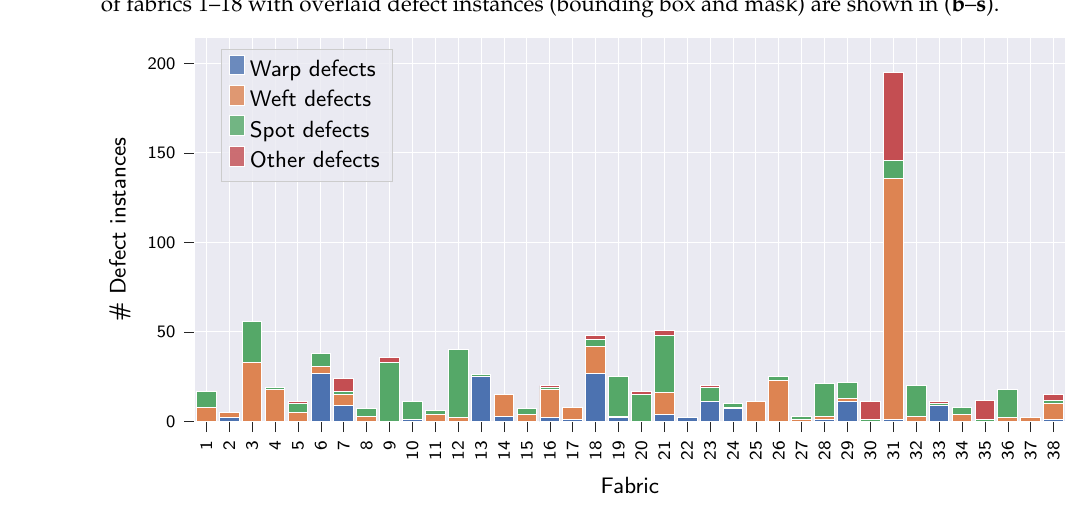
Figure 3. Class distribution of defect instances in the OLP